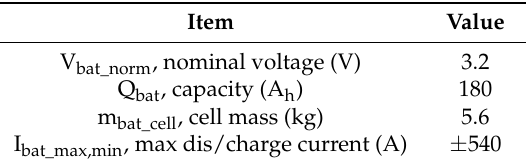
Table 1. Basic parameters of the LiFePO 4 battery cell.